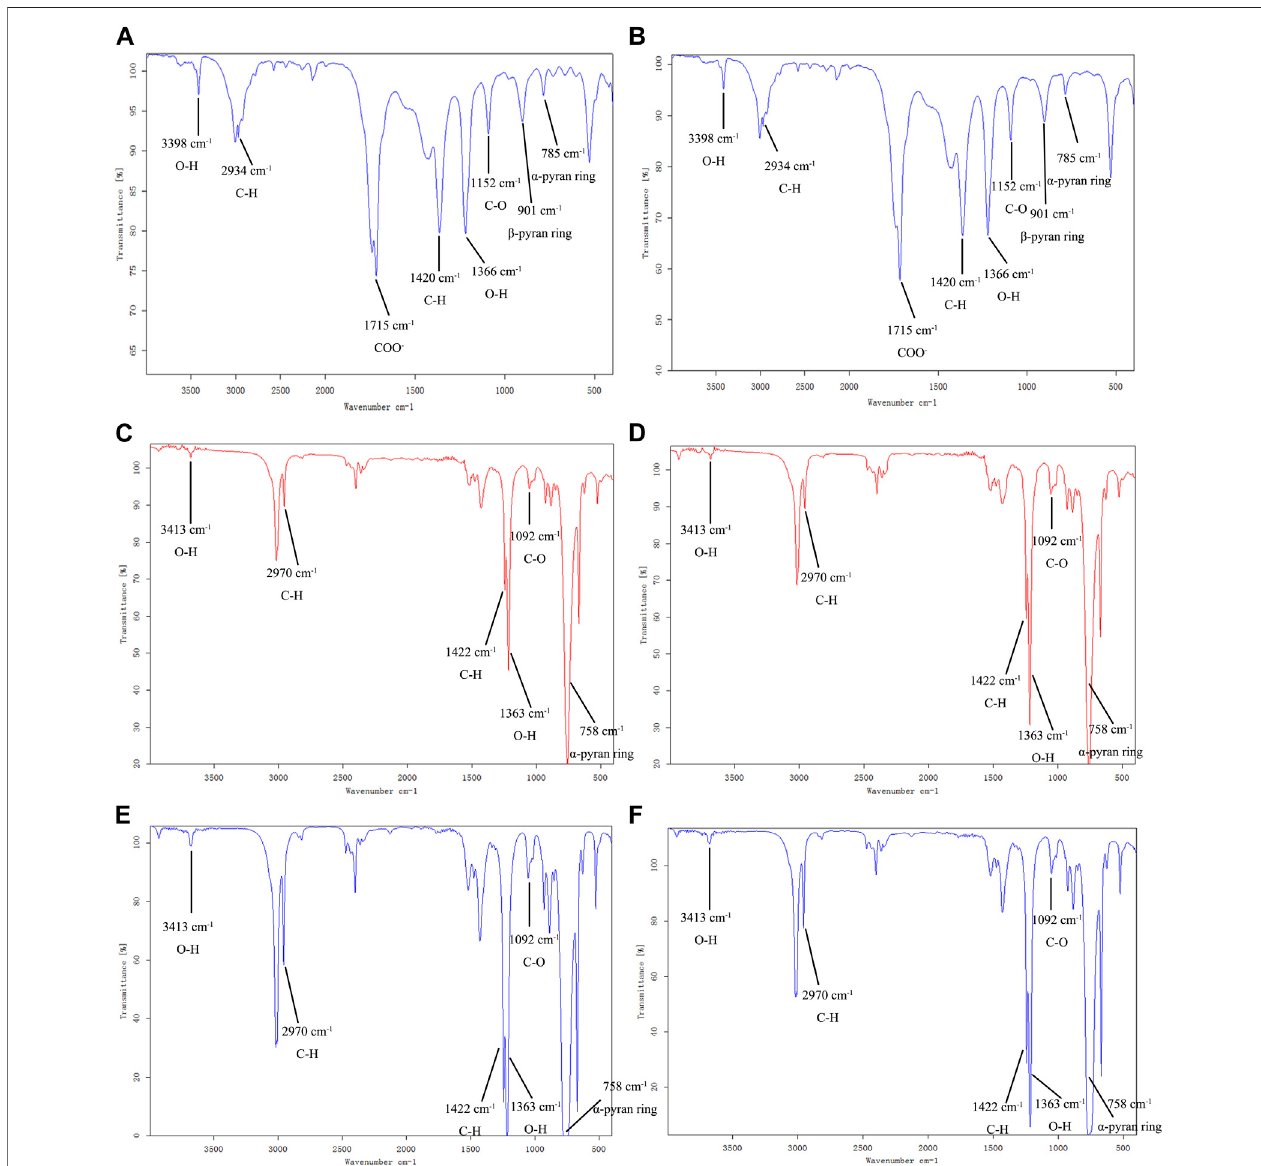
FIGURE 3 | FT-IR spectra of APS-II (A) , APOS (B) , P1 (C) , P2 (D) , P3 (E) and P4 (F) .